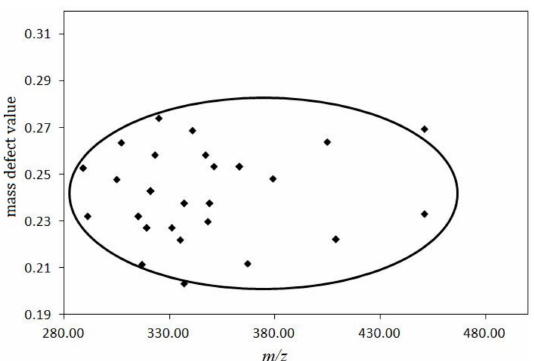
Figure 3. Mass defect filtering value distribution of 8, 13-epoxy-14 ene labdane type